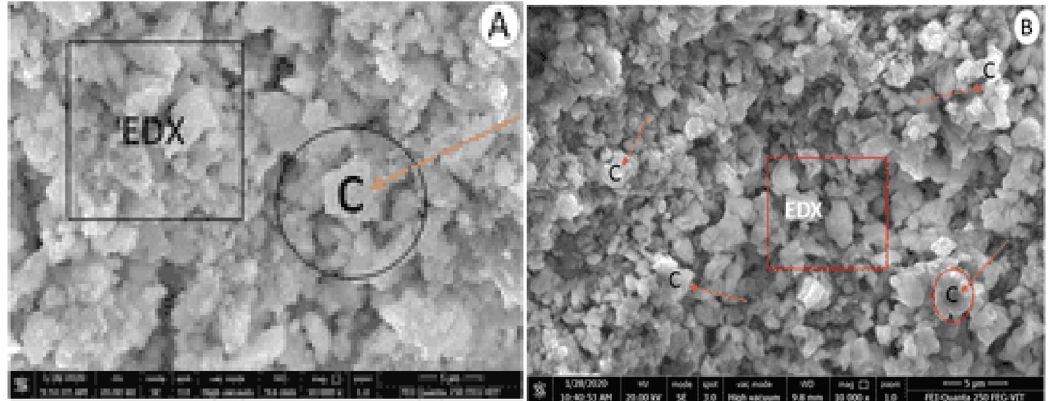
Figure 9. FESEM-EDX Images of modified organic lime paste ( a ). Kadukkai lime paste ( b ). Neelamari lime paste.